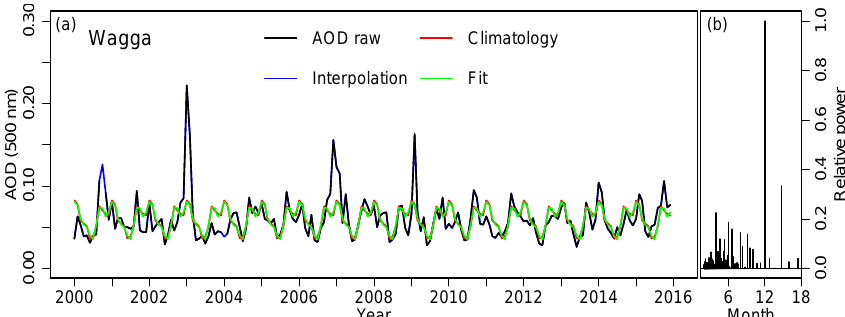
Figure 4. (a) Time series of monthly mean aerosol optical depth at 500nm at Wagga Wagga. The raw data are shown in black, the (repeated) climatology in red, the interpolated data in blue (see text), and the model fit in green. (b) The power spectrum of the interpolated time series computed using a fast Fourier transform (FFT).